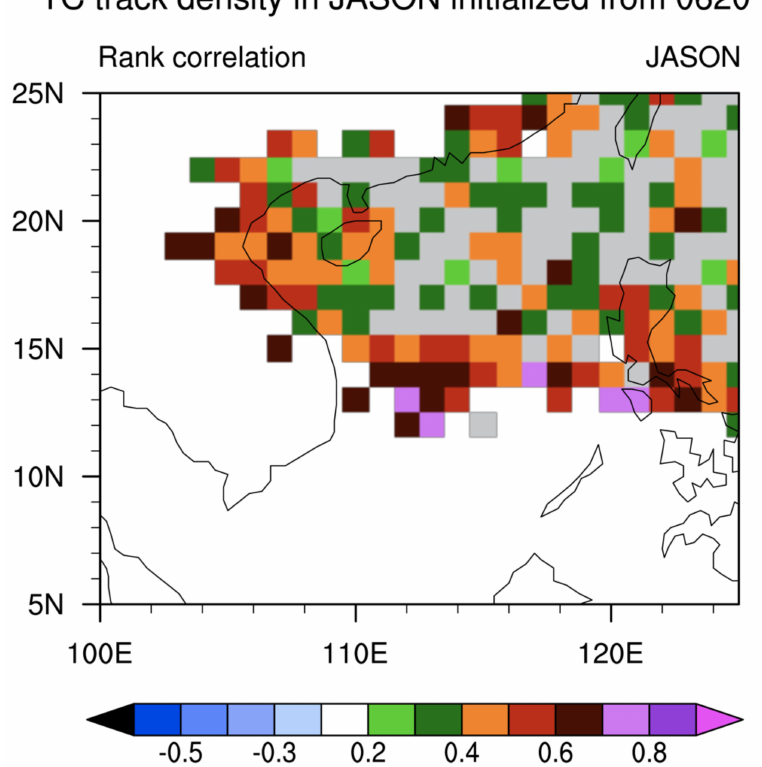
Figure 3. The rank correlation between the IBTrACS and the hindcast of FGOALS-f2 based on the track density of TCs in the SCS. Data are analyzed in a 1 ◦ × 1 ◦ equidistance grid box with six-hour intervals. Color shading indicates the correlation coefficients that are significant at a two-sided P = 0.1 level. The grey shading indicates the regions where the observed track density is non-zero for at least 25% of the years (approximately 9